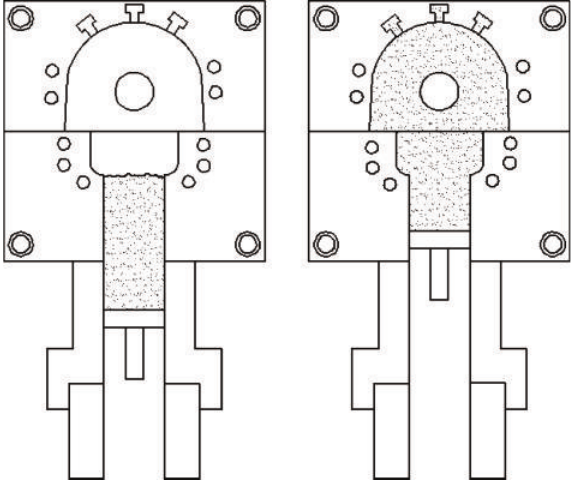
Figure 9: The plunger position for variation of velocity.